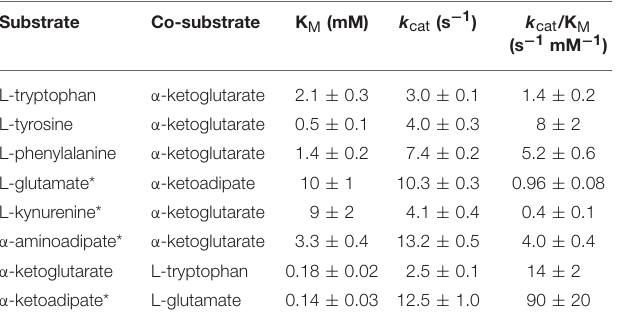
TABLE 1 | Steady-state kinetic parameters of AroH for the transamination reaction. Substrate